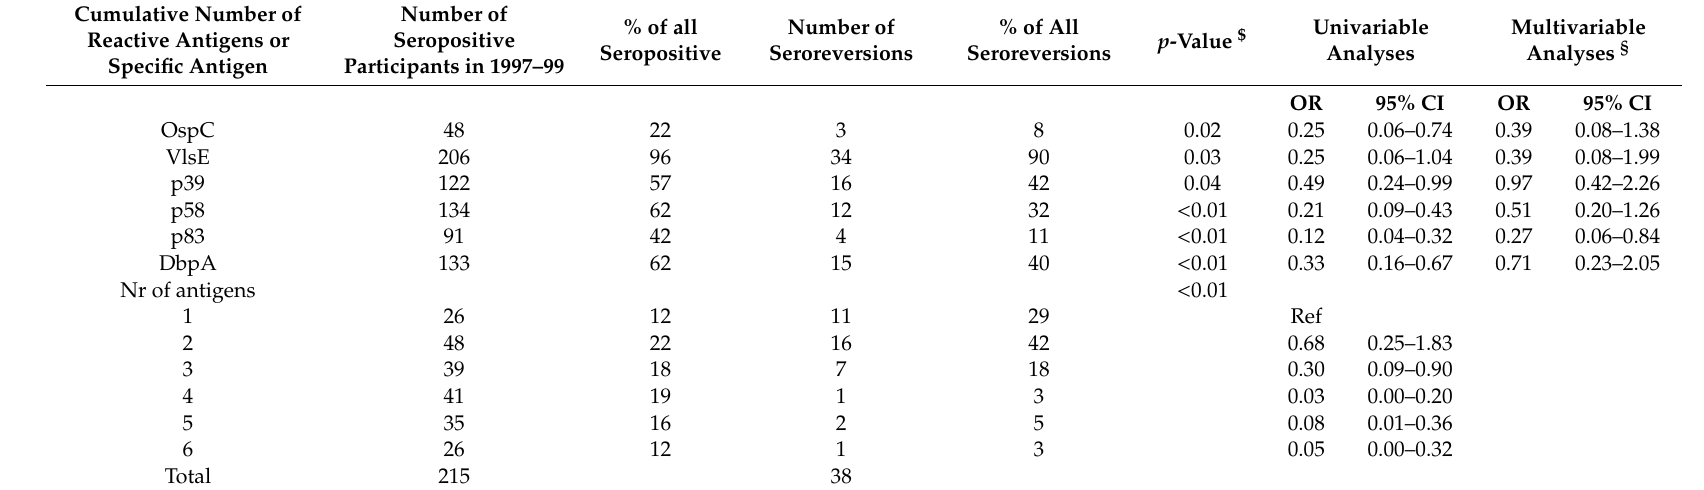
Table 3. The association between seroreversion and antigen-specific antibodies in the immunoblot among 215 individuals who tested positive in a serosurvey in 1997–1999 and were retested in 2008–2011. Cumulative Number